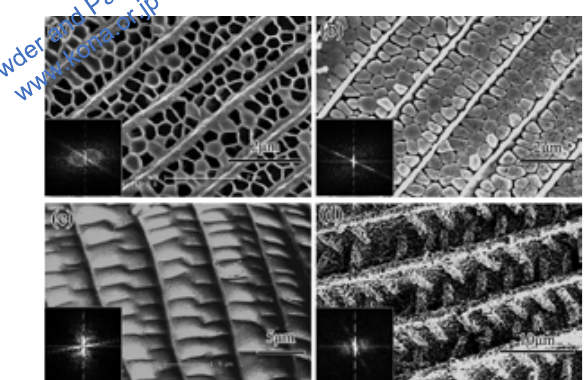
Fig. 18 FESEM images of as-synthesized titania pho- toanodes templated from butterfly wings with different colors. (a, b) Quasi-beehive structures synthesized in different conditions; (c, d) shal- low concavities structures in different condi- tions.